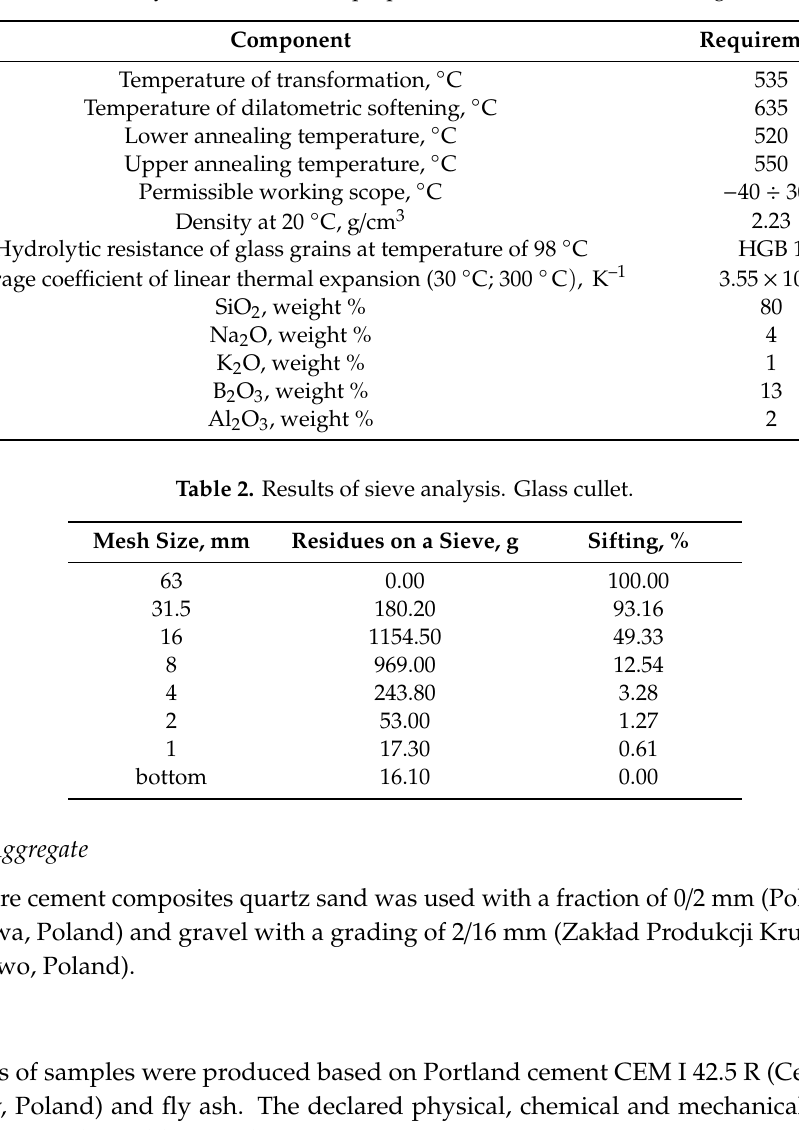
Table 1. Physical and chemical properties of TERMISIL borosilicate glass.